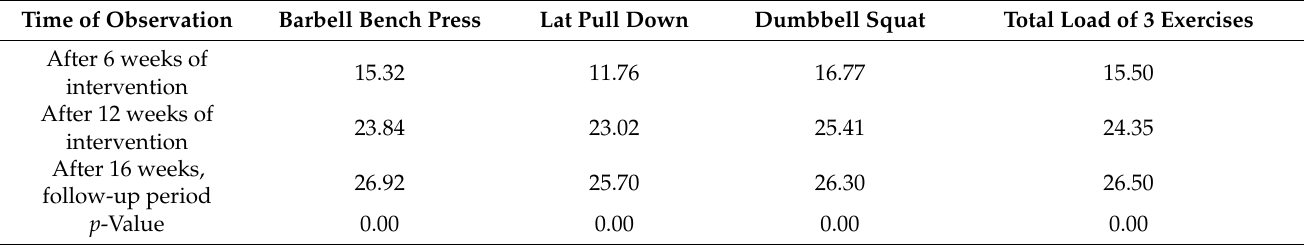
Table 1. The progression of load [%] in selected resistance exercises during the intervention and follow-up compared to baseline in the aerobic-resistance group